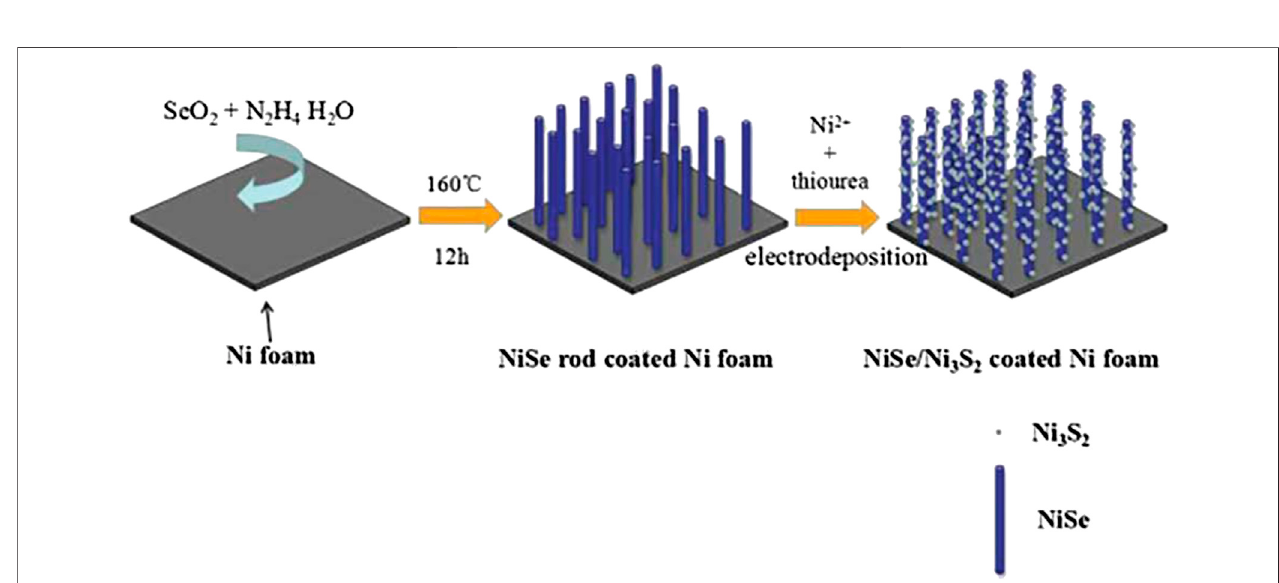
FIGURE 16 | Electrodeposited NiFe 2 Se 4 on nickel foam as a binder-free electrode for high-performance asymmetric supercapacitors.